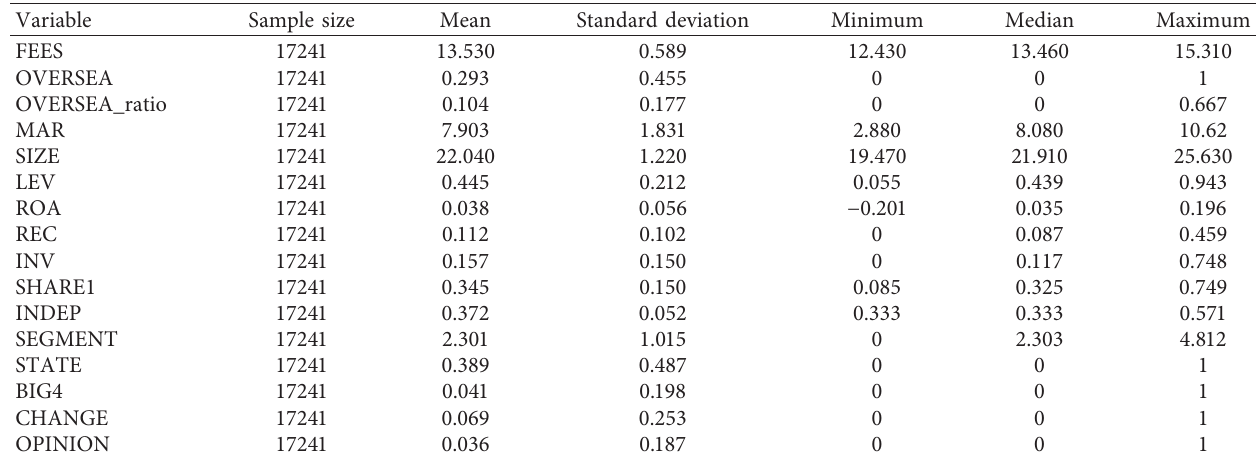
Table 2: Descriptive statistics.